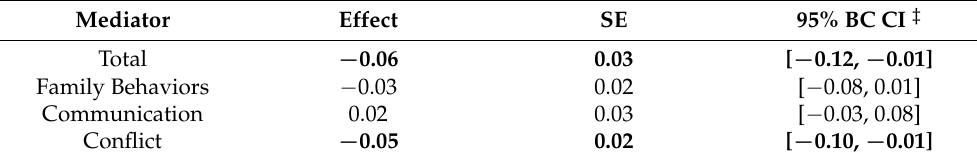
Table 4. Indirect Effects of Fam-B on Staff Behavior through Interaction Variables ( N = 178).